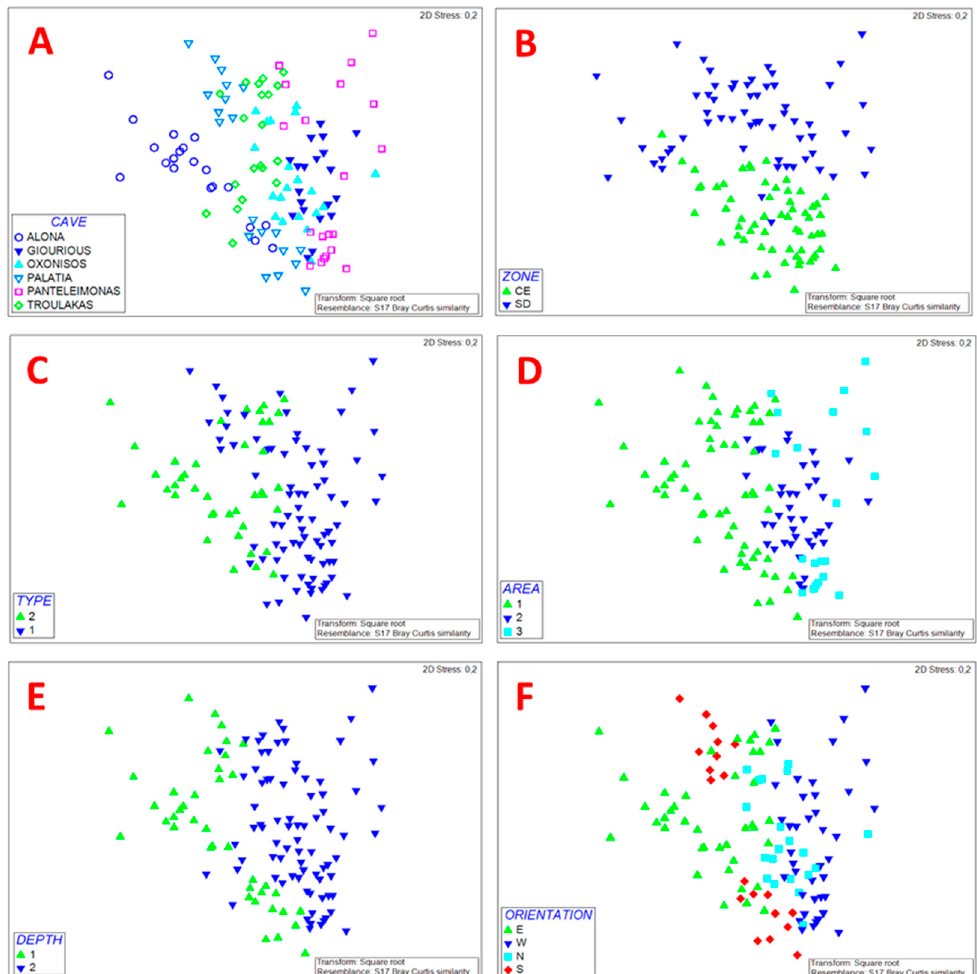
Figure 4. Non-metric multidimensional scaling (nMDS) plots showing the similarities among the analysed photoquadrat samples from all caves. Photoquadrats are coloured by different factors. ( A ) Cave; ( B ) Ecological Zone: entrance (CE) or semi-dark (SD); ( C ) Cave Type: semi-submerged (1) or submerged (2); ( D ) Entrance Area: 15–40 m 2 (1), 110–230 m 2 (2), or 630 m 2 (3); ( E ) Entrance Depth (max): 0–10 m (1) and 10–20 m (2); ( F ) Entrance Orientation: east (E), west (W), north (N), and south (S).